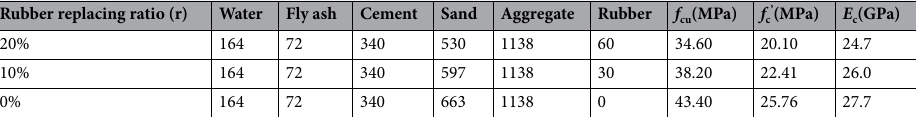
Table 3. Mixture of concrete (kg/m 3 ) and material properties of rubber concrete.